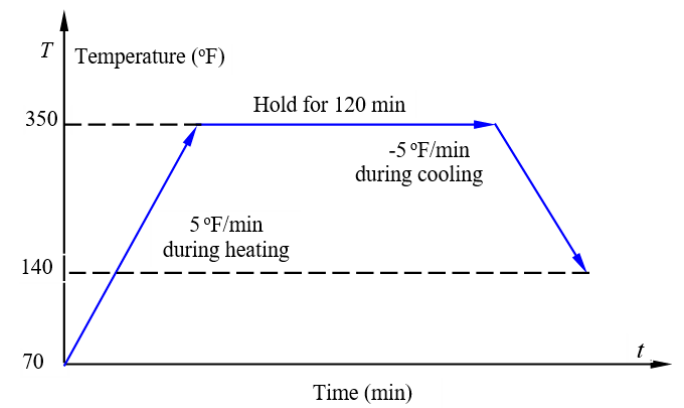
Figure 2. Curing cycle of the Hexcel T2G-190-12-F263 prepregs.